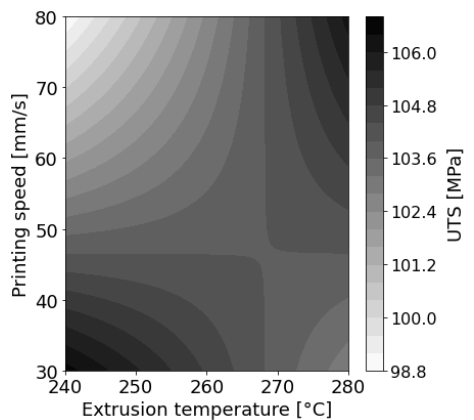
Figure A1. Contour plot for T ext and v based on DoE prediction model.